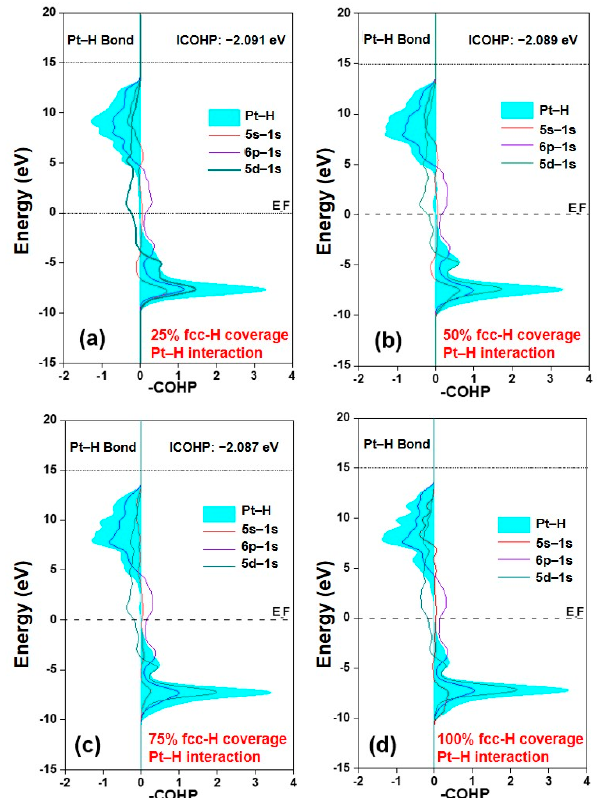
Figure 4. The negative-value crystal orbital Hamiltonian populations of Pt–H bonds at 25% ( a ), 50% ( b ), 75% ( c ), and 100% ( d ) fcc-H coverage.